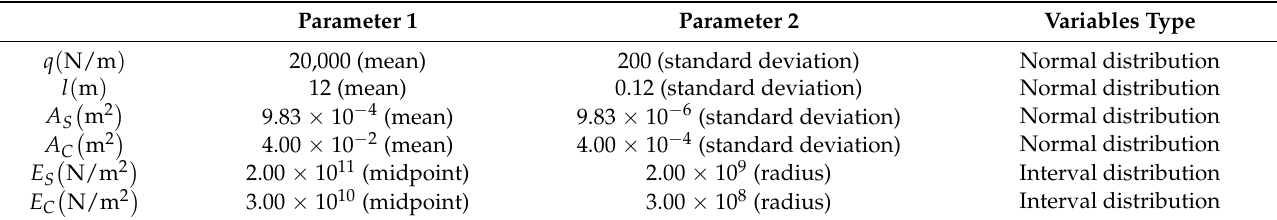
Table 3. Distribution of the variables in Section 4.1.